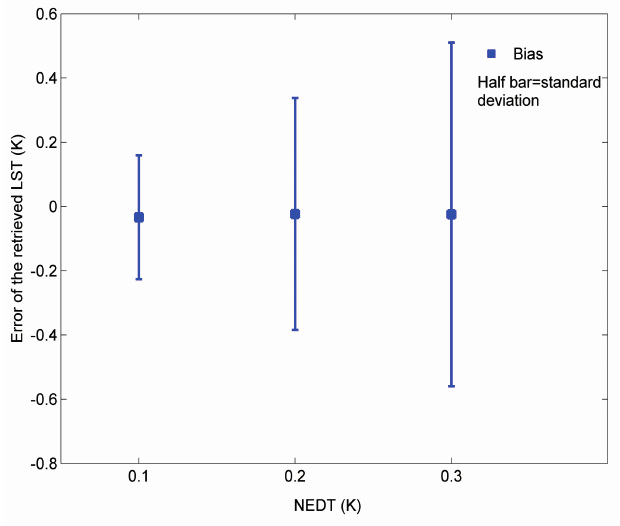
Figure 9. Errors of the ST retrieved using Equation (3) from each the three simulation databases as a function of instrumental noise.